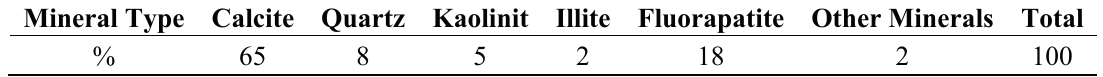
Table 1. X-ray diffraction (XRD) analysis of a representative phosphate ore sample from the Lar Mountains.